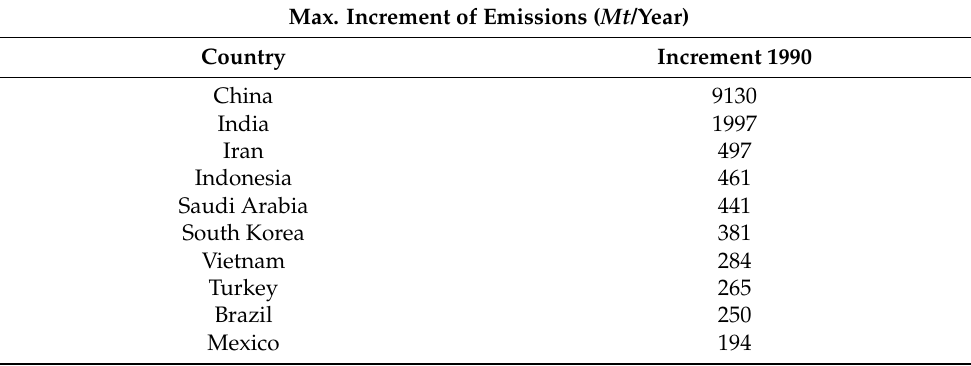
Table 4. Ten countries with the greatest increment in emissions. Own